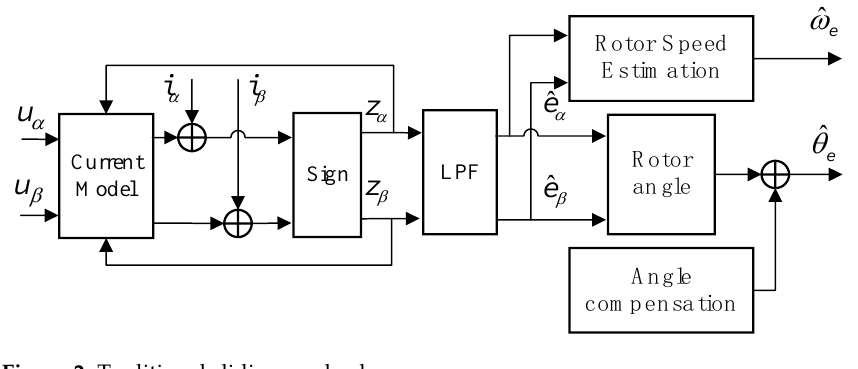
Figure 2. Traditional sliding mode observer.